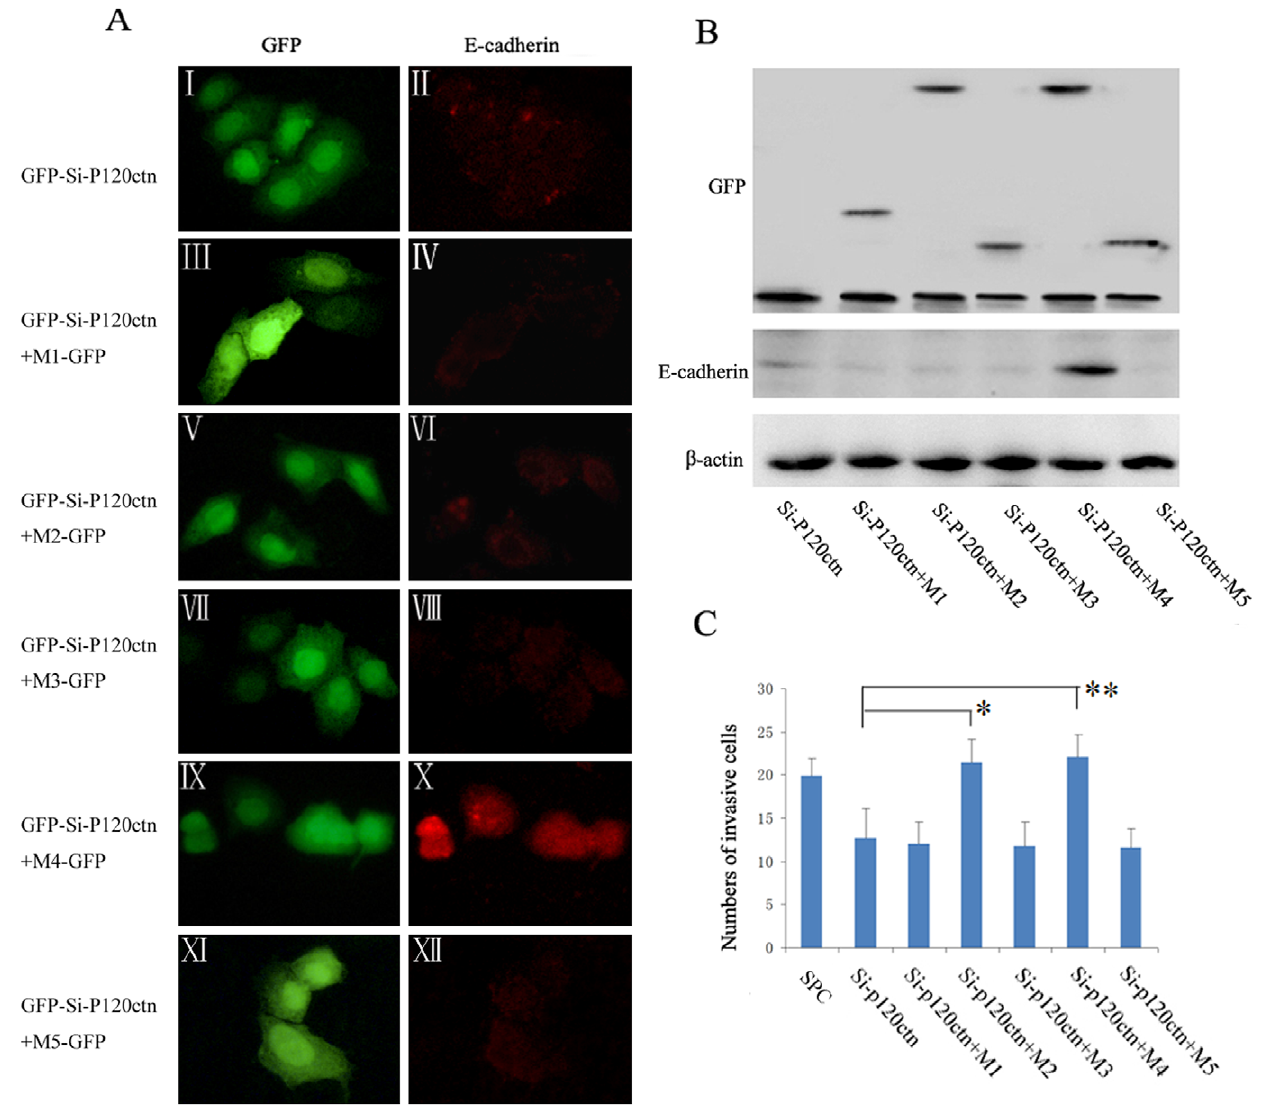
Figure 6. Mutant 4 restored cytoplasmic E-cadherin and enhanced the invasiveness in SPC cells. SPC cells were transiently transfected with GFP-siRNA-p120ctn plasmids. 24 hours after transfection, an aliquot of the cells was transfected again with one of the five p120ctn isoform 1A deletion mutants M1–5 cDNA plasmids or with empty vector as control (The group transfected with vector alone was not included in the data). ( A ) Levels and localization of E-cadherin were analyzed by immunofluorescence. The green signal indicates expression of GFP from GFP-siRNA-P120ctn construct in image I and represents combined expression of GFP from GFP-siRNA-P120ctn and M1–5-GFP in images III, V, VII, IX and XI. GFP from GFP- si-P120ctn or M1–M5-GFP was expressed in the nucleus and cytoplasm. Expression (repletion) of M4 mutant (IX) restored cytoplasmic E-cadherin (X), while expression of the other mutants had no significant effects on the E-cadherin levels. ( B ) The levels of E-cadherin were analyzed by Western blot assay. Expression of M1–M5 mutants was detected by using antibody against GFP. The results showed that expression of M4 mutant up-regulated E- cadherin levels, whereas expression of the other mutants had no effects on the E-cadherin levels. ( C ) The invasiveness of SPC cells was analyzed by Matrigel invasion assay. Expression of M2 or M4 mutants enhanced the cell invasiveness in comparison with the group with ablated p120ctn (Si- p120ctn) (*, P , 0.01, **, P , 0.01), while expression of other three p120 1A mutants did not show significant effects.